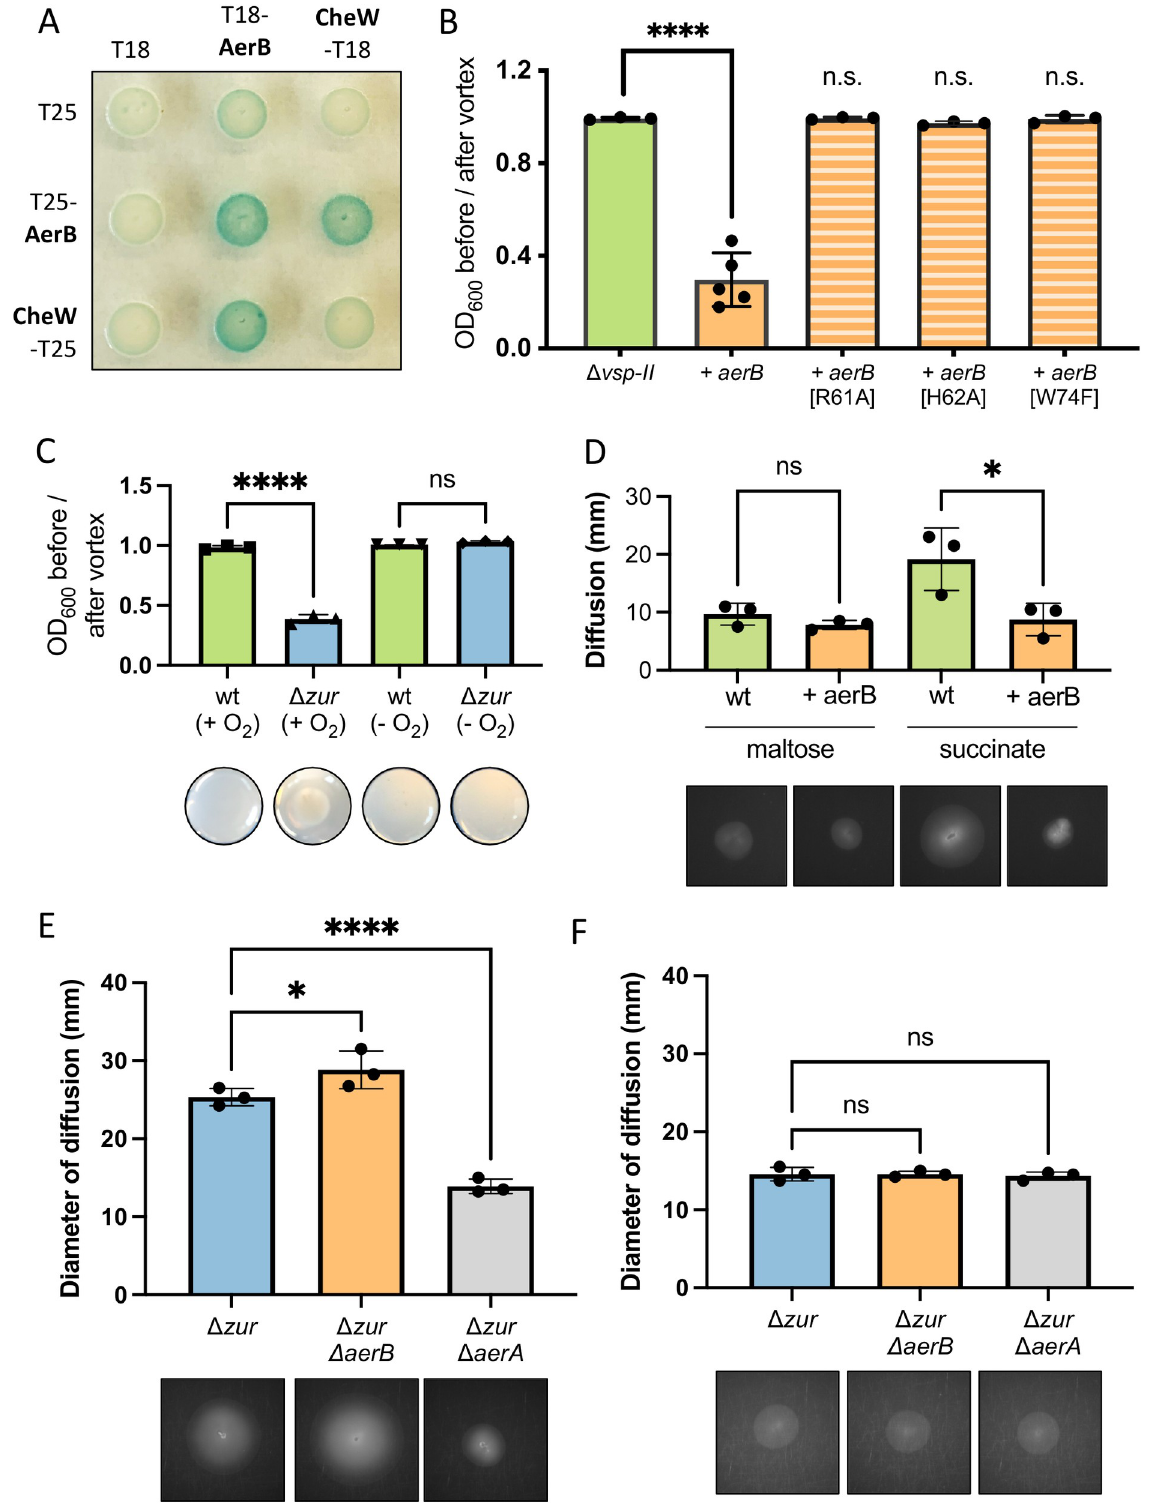
Fig 5. AerB encodes a methyl-accepting chemotaxis protein involved in energy taxis. ( A ) In a bacterial two-hybrid assay, E . coli BTH101 was co-transformed with vectors carrying one domain of adenylate cyclase (T18 or T25) or an adenylate cyclase fusion with a protein of interest: CheW-T(18/25) or T(18/25)-AerB. Co-transformants were spotted onto an LB agar containing kanamycin and ampicillin (for